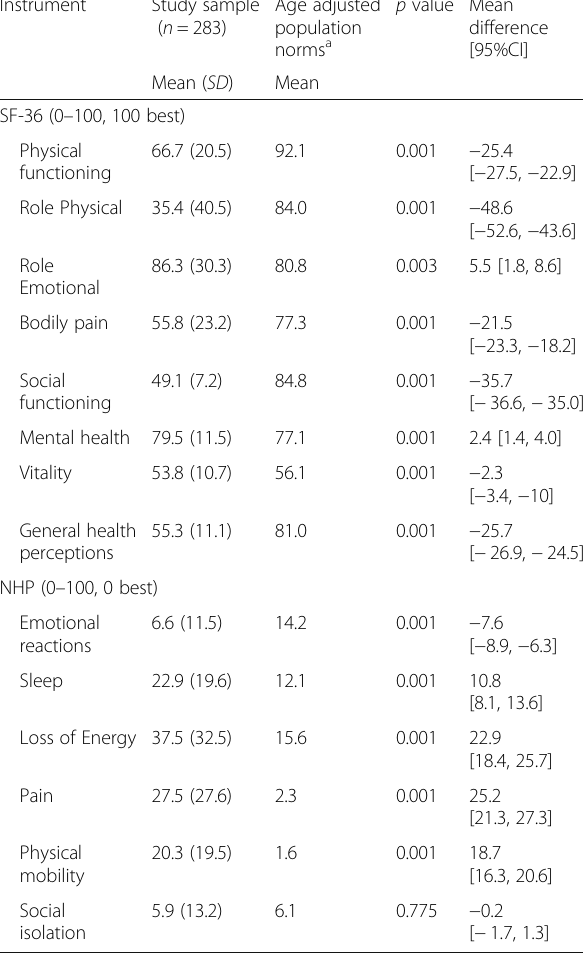
Table 2 Comparisons between the study sample and the age adjusted mean values from population norms for the SF-36 and NHP using one sample